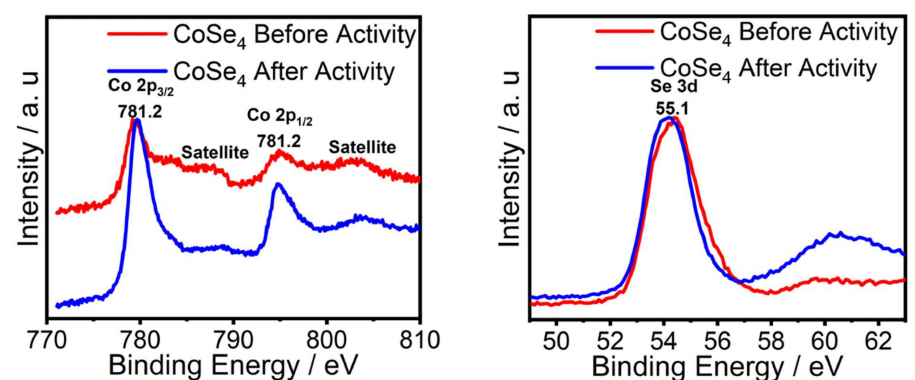
Figure 5. Comparison of XPS peaks of Co 2p and Se 3d before and after OER activity confirming the stability of the CoSe 4